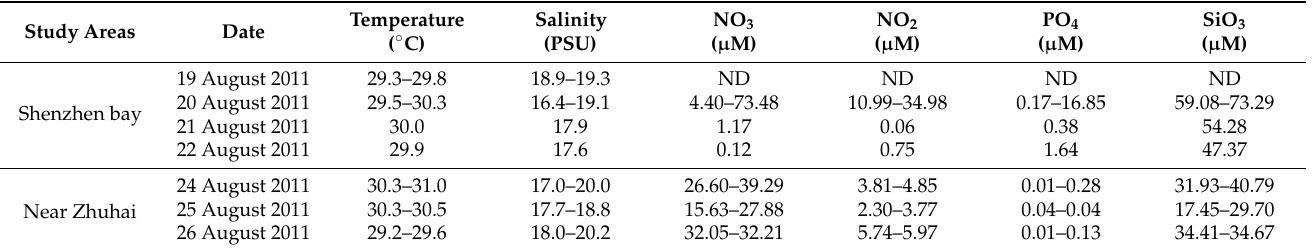
Table 1. Environmental variables in Polykrikos geminatum bloom surface waters in the Pearl River Estuary, August